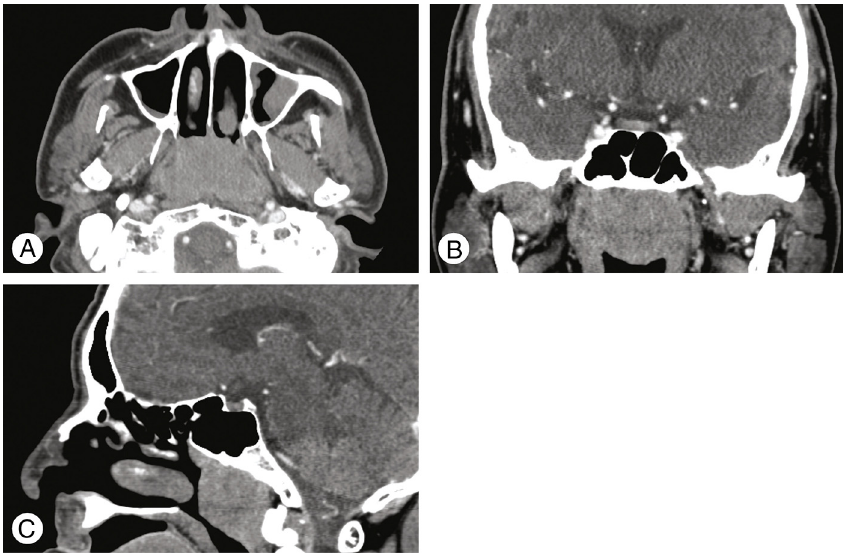
Figure 1 Computed tomography (CT) of paranasal sinus. Contrast-enhanced CT images show a bilateral, homogenous, mildly- enhanced solid mass from nasopharynx extending to upper oropharynx on axial (A), coronal (B), and sagittal (C) view. small lymphocytic cells with mild nuclear atypia (Fig. 3A). A bone marrow biopsy showed no abnormalities. The patient Immunochemical staining revealed that the neoplastic lym- was staged IE according to the Ann Arbor staging system. phocytes were strongly positive for CD 20, CD5, and cyclin D1 (Fig. 3B---D). These findings were consistent with MCL. An upper gastrointestinal endoscopy, bone scan, and CT scan of the chest, abdomen, and pelvis were all reported as normal.